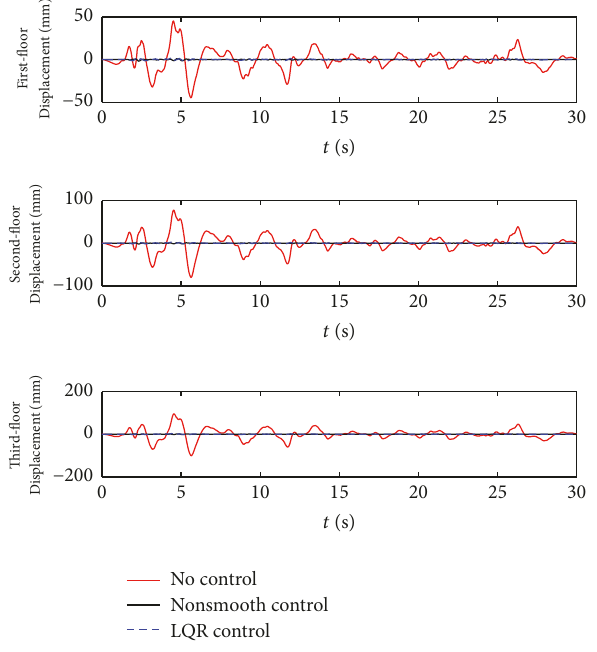
Figure 8: Displacement response of example 2. Table 3: Maximum displacement of each layer of example 2 (mm).